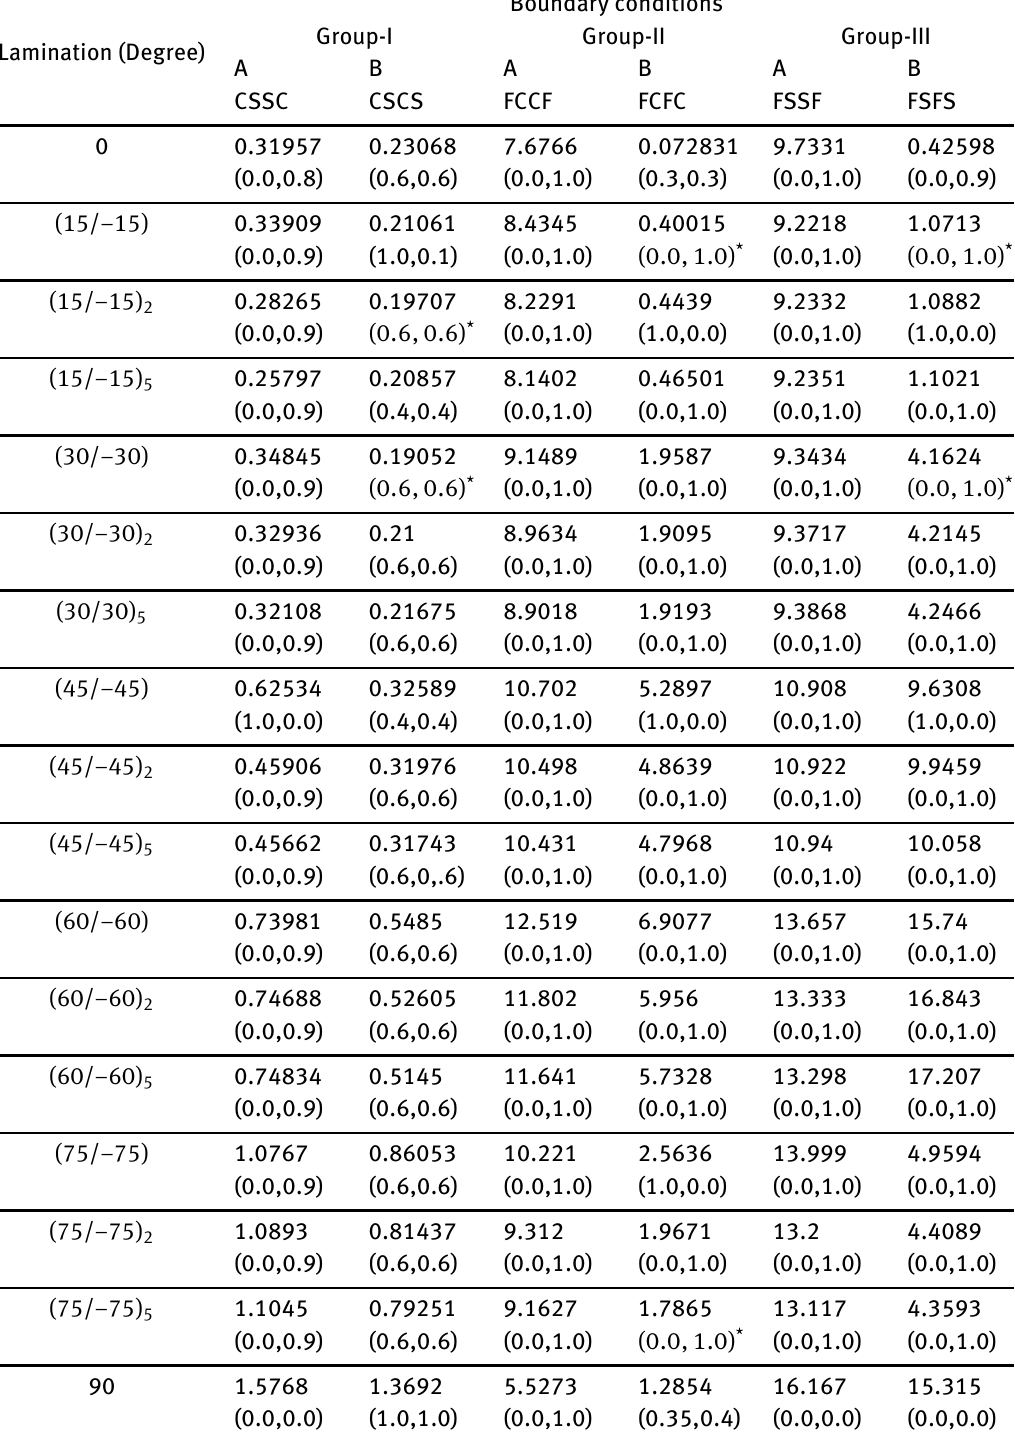
Table 4: Values of maximum non-dimensional tensile in-plane forces (+ N x ) for different antisymmetric angle ply lami- nation and boundary conditions of stiffened composite hypar shell with